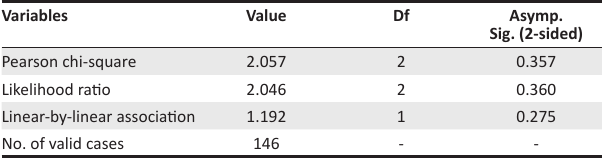
TABLE 3a: Marketing constraint: chi-square